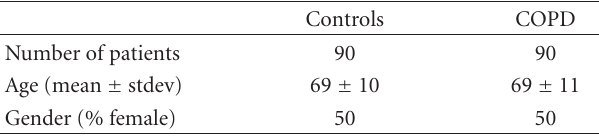
Table 1: The number of patients, their age and gender in each diagnostic category.